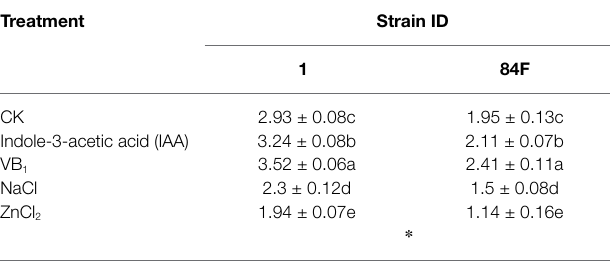
* in the table indicates significant differences between different strains (p < 0.05). Different lowercase letters in the table indicate significant differences between different exogenous additives (p <